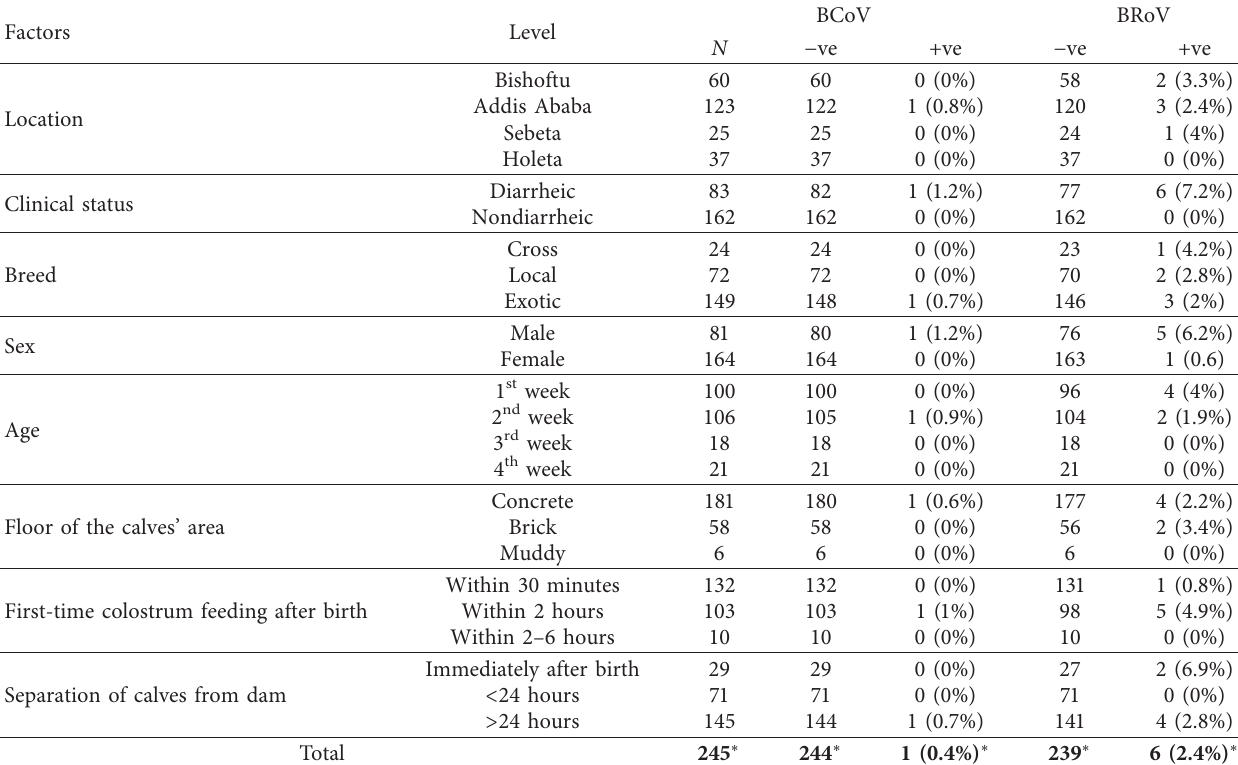
Table 2: Frequency distribution of bovine coronavirus (BCoR) and bovine rotavirus (BRoV).